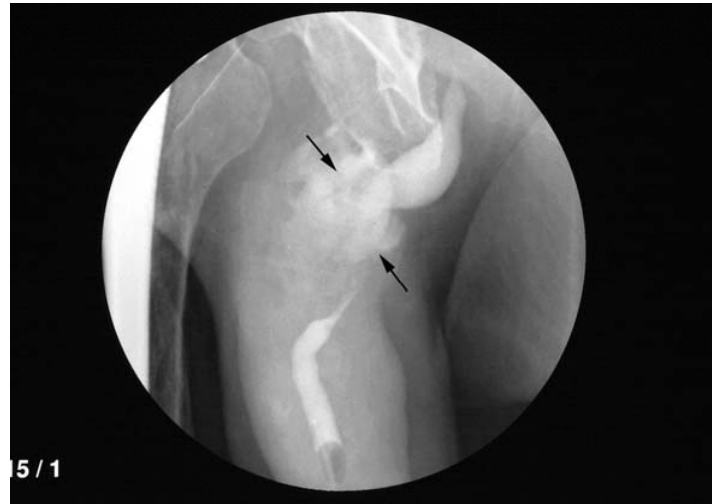
FIGURE 1. Cystogram: contrast fills a fairly short segment of urethra and then there is marked extravasation of contrast (arrows) through a sinus near the penoscrotal junction.